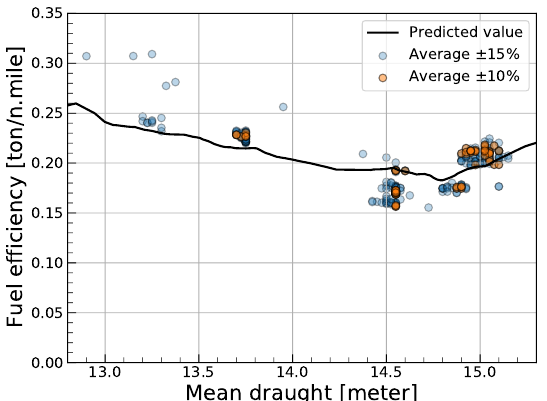
Figure 12. Sensitivity analysis of DFT under average operating conditions of the